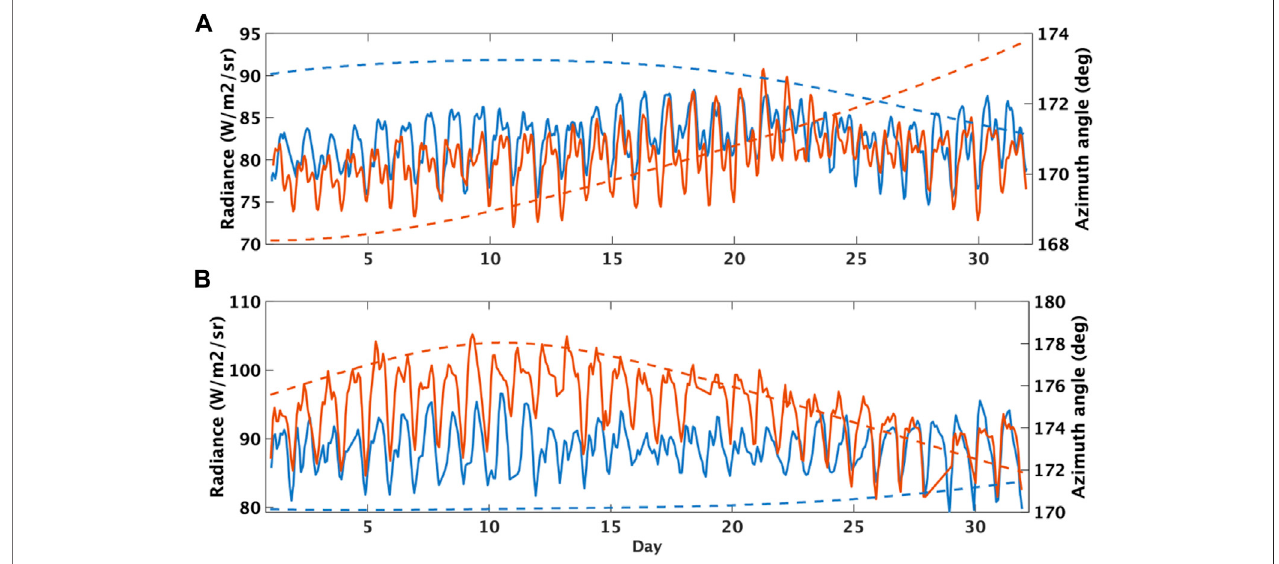
FIGURE3| ComparisonofglobaldaytimemeanEPICshortwaveradiances (leftaxis,solidlines) andrelativeazimuthangels (rightaxis,dashedlines) between 2017 and 2020 for (A) May and (B) December. Blue lines are for 2017 and red lines are for 2020.